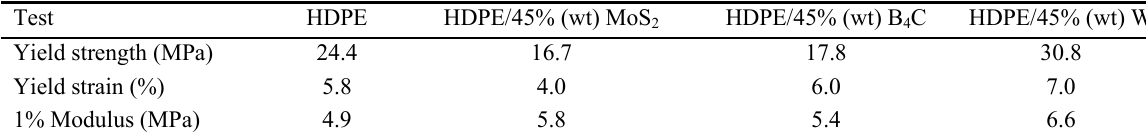
Table 5. Tensile Test Results